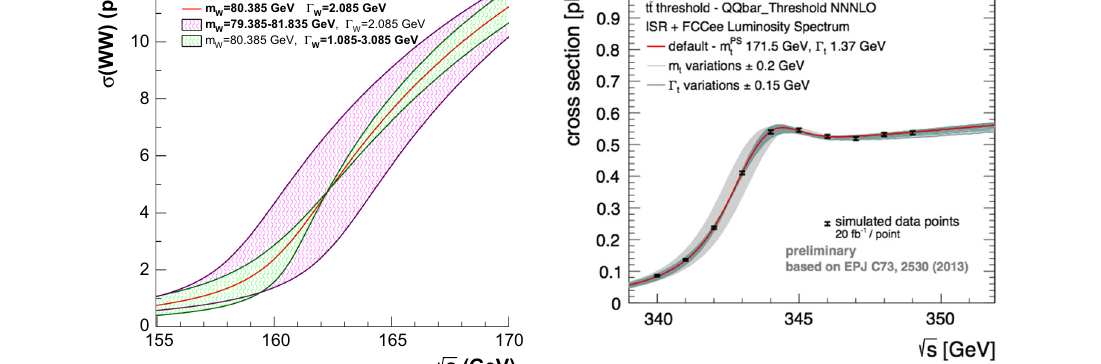
panel,thegreyandgreenbandsincludevariationsofthetop-quarkmass and width by ± 0 . 2 and ± 0 . 15 GeV. The dots with error bars indicate the result of a 10-point energy scan in steps of 1 GeV, with 0.02 ab − 1 per